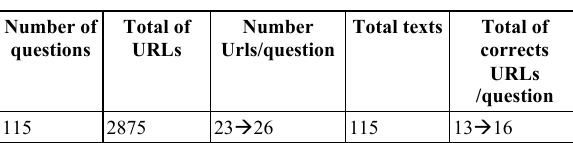
TABLE I. S TATISTIC OF OUR CORPUS AQA-W EB C